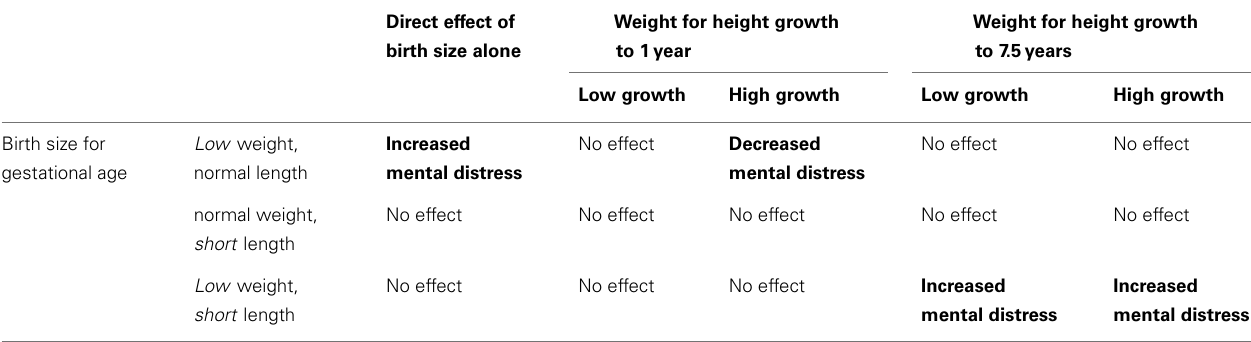
Table 3 |The combinations of growth restriction and early growth considered, along with their observed effect on mental distress in the Pathways toAdulthood Study subsample of the JHCPS